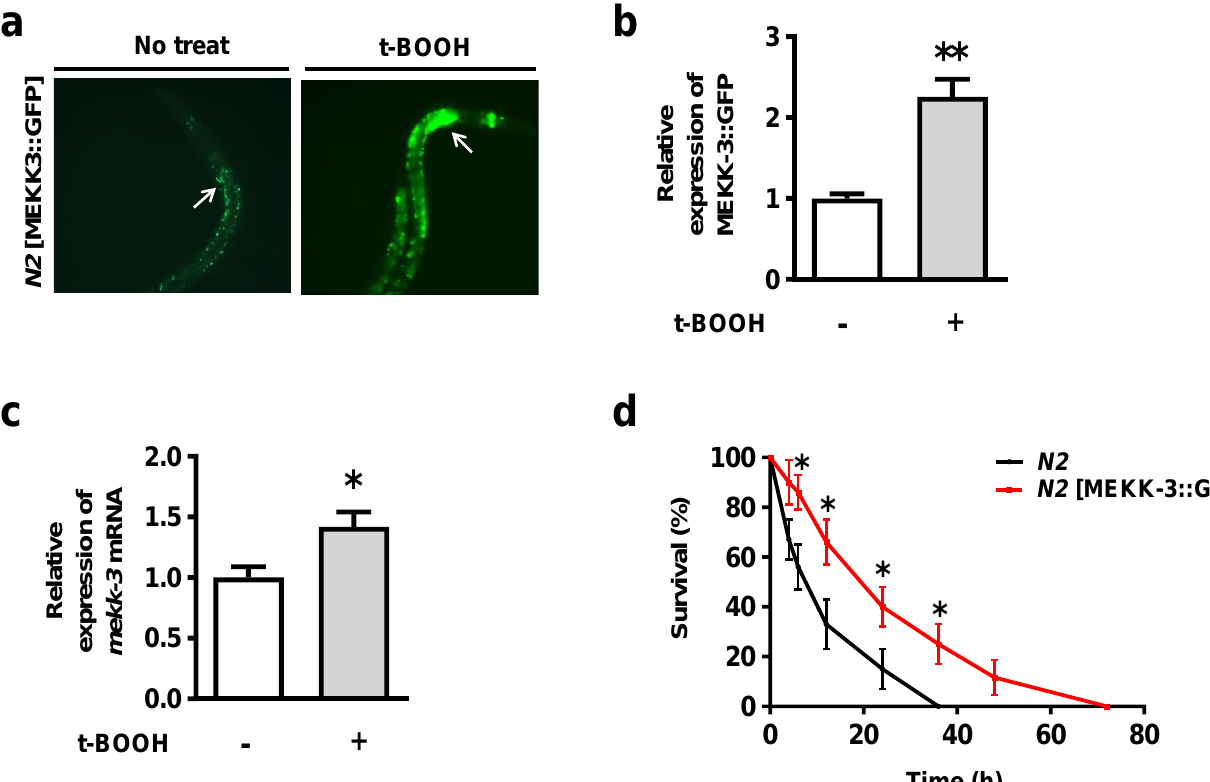
Figure 2. Expression of MEKK − 3 in oxidative stress. ( a ) Localization of MEKK-3 labeled with GFP under normal conditions (left) and under treatment with 7.5 mM t-BOOH for 24 h (right). MEKK-3 transgenic worms were visualized by GFP expression using fluorescence microscopy. The white arrows indicate the MEKK-3::GFP protein in the intestine. ( b ) Quantification of MEKK-3::GFP was performed using the ImageJ software and summarized ( n = 3). ( c ) Quantitative PCR analyses of mekk-3 ( n = 3). Total RNA extraction from MEKK-3 transgenic worms was performed 24 h after the exposure to 7.5 mM t-BOOH. ( d ) Oxidative stress resistance assay for MEKK-3 transgenic worms. The survival rate was calculated at the indicated time points (h) after the exposure to 7.5 mM t-BOOH. This representative experiment involved 30 worms in each group. Data are shown as the mean ± SEM. * p < 0.05. ** p < 0.01. All p values were calculated by unpaired two- tailed Student’s t - tests.